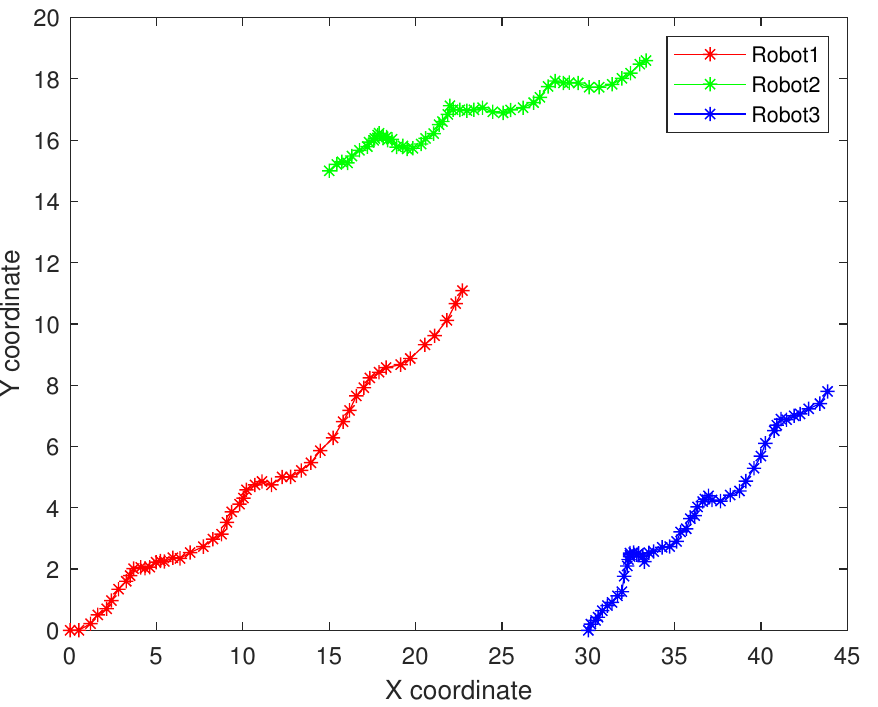
Figure 4. The real trajectory of the fixed multi-robot formation.